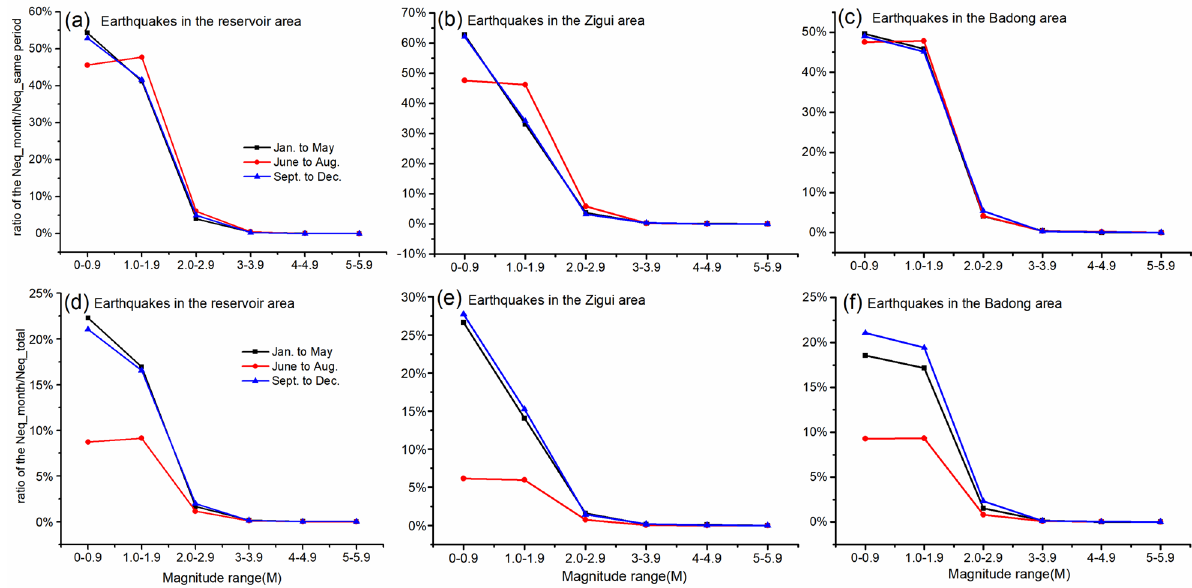
Figure 5. Monthly proportions of earthquakes of different magnitudes in the Three Gorges Reservoir area and the Zigui and Badong subregions at different loading and unloading